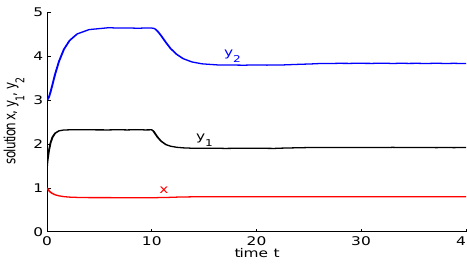
Figure 5: µ = 20 , τ = 10 , E * = (0.7953, 1.9162, 3.8323) of system (1.4) is locally asymptotically stable.